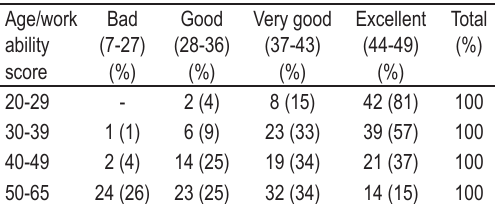
TABLE 3. Subjectively perceived work ability in relation to the age groups